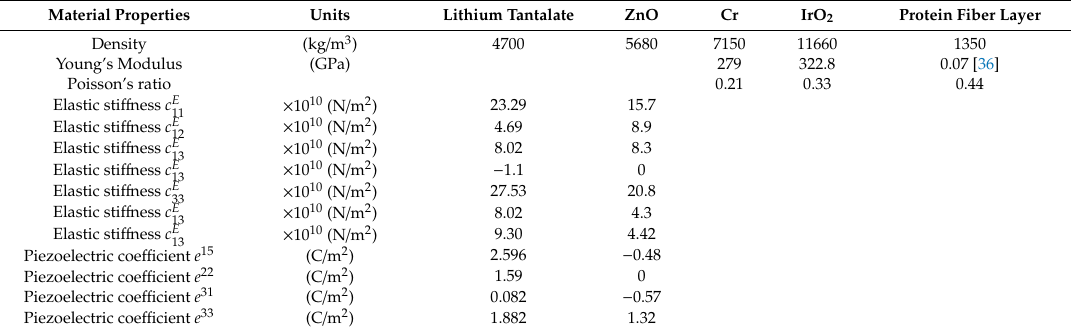
Table 2. Material properties used in COMSOL and Matlab ©